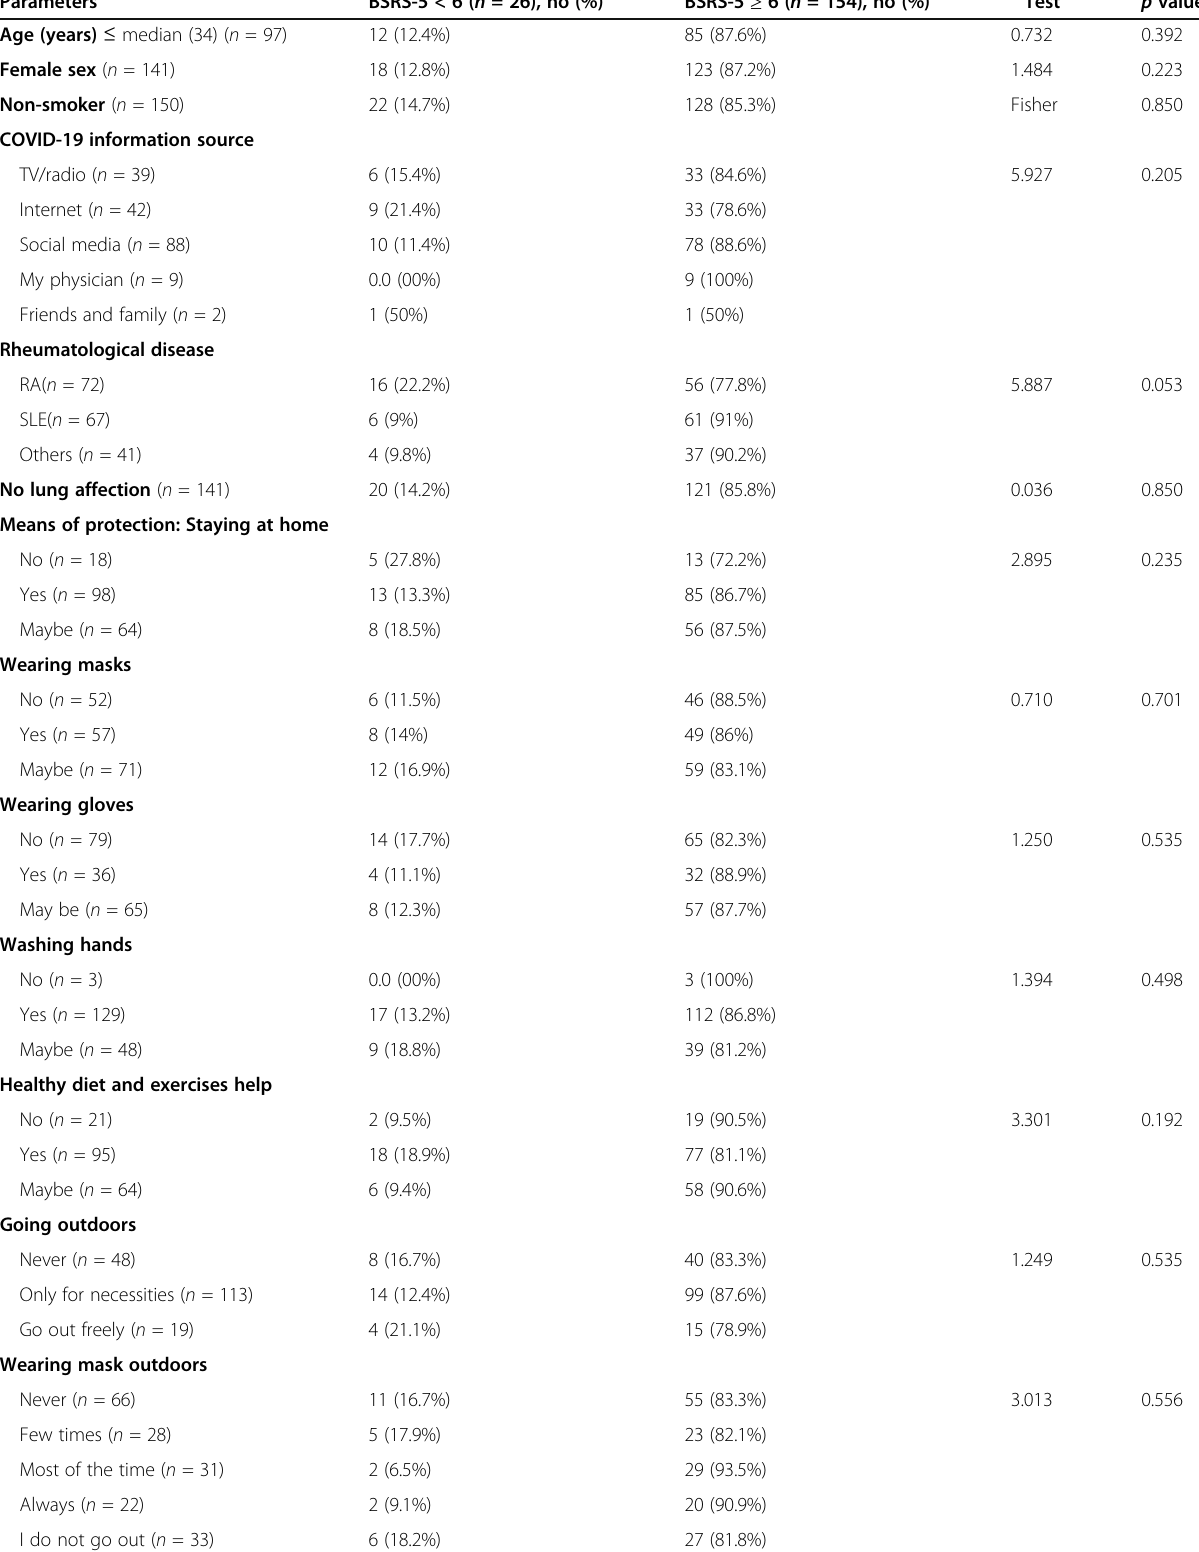
Table 5 Relation between different parameters and patients ’ mental health ( n = 180)